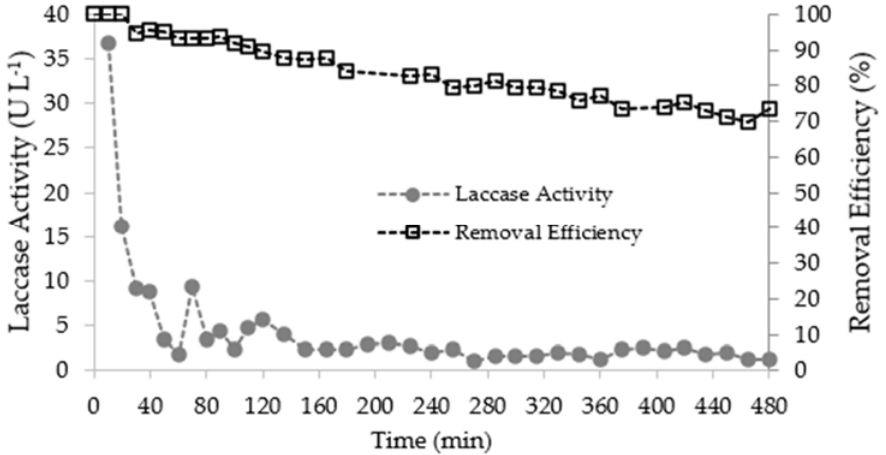
Figure 6. Progression curves of laccase activity and fluoxetine removal efficiency in the column outlet solution over time.